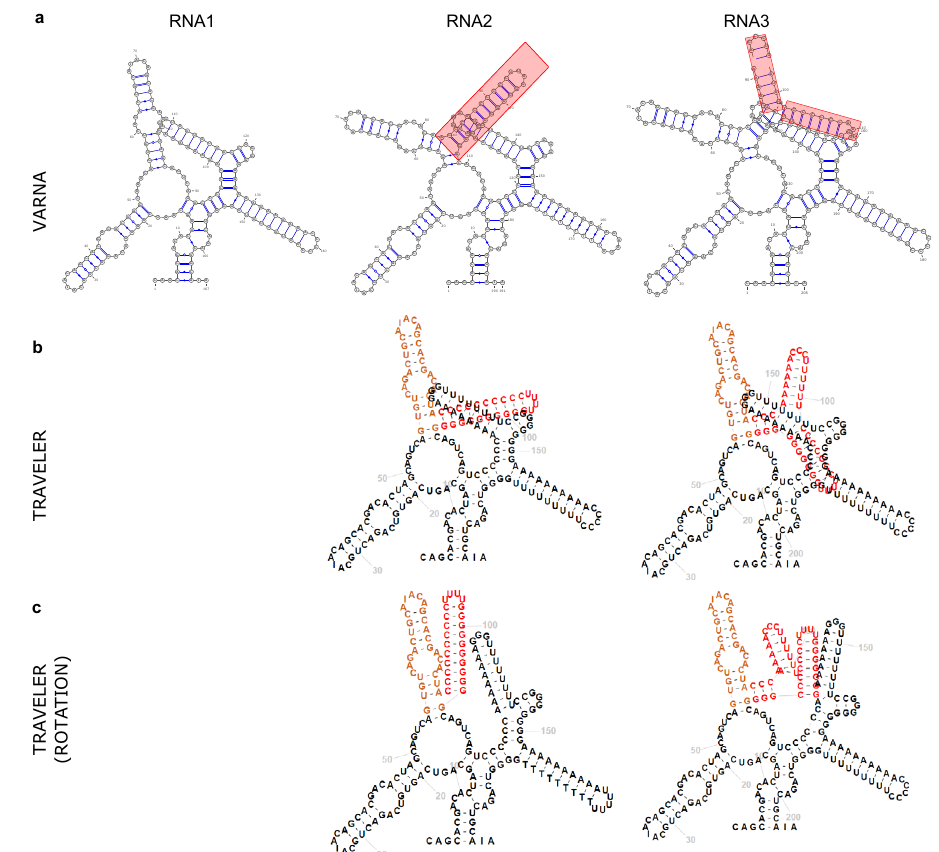
Fig. 6 Examples of handling overlapping secondary structure elements with the Traveler software. Sequences RNA2 and RNA3 contain insertions (shown in orange and red) with respect to sequence RNA1. a The 2D layouts generated by VARNA (v 3.9); b The layouts for RNA2 and RNA3 generated by Traveler when using RNA1 as a template; c Same as b using Traveler overlap detection and correction. All sequences have been arti fi cially generated to highlight issues with overlapping secondary structure